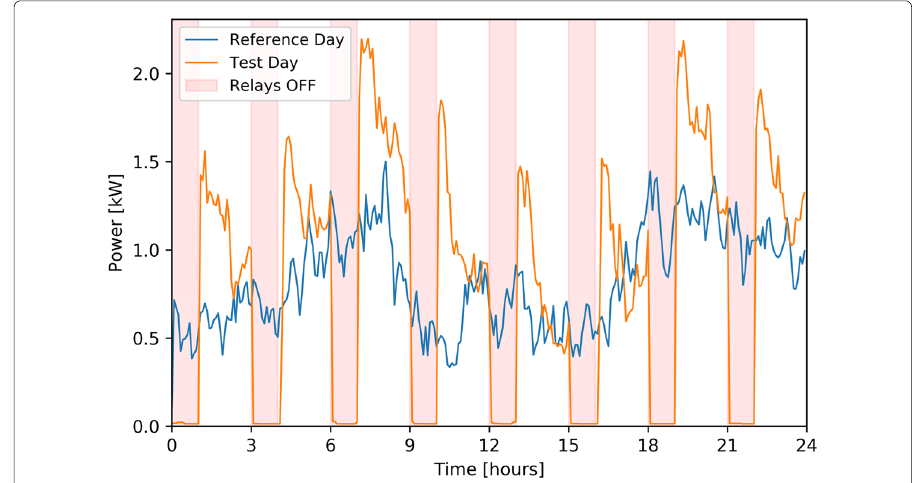
Fig. 9 Average heating appliances power of 73 households during a reference day and during a day when regular 1 hour cuts of the appliances were implemented. The rebounding effect is clearly visible as well as a slight oscillation induced by a synchronization of some of the appliances after the cut. The respite period of 2 hours between the cuts seem also to be fitting to restabilize the system after the